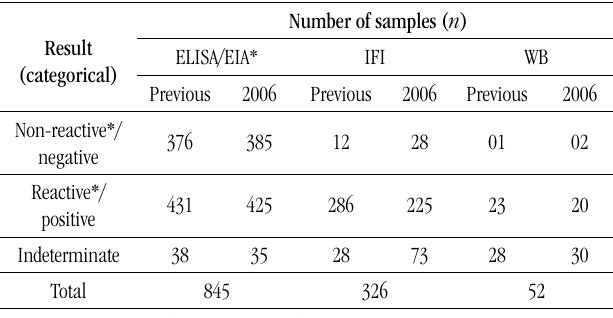
tABLE 2 – Number of samples with reactive/positive, non-reactive/negative and indeterminate results previously detected and those obtained 2006.